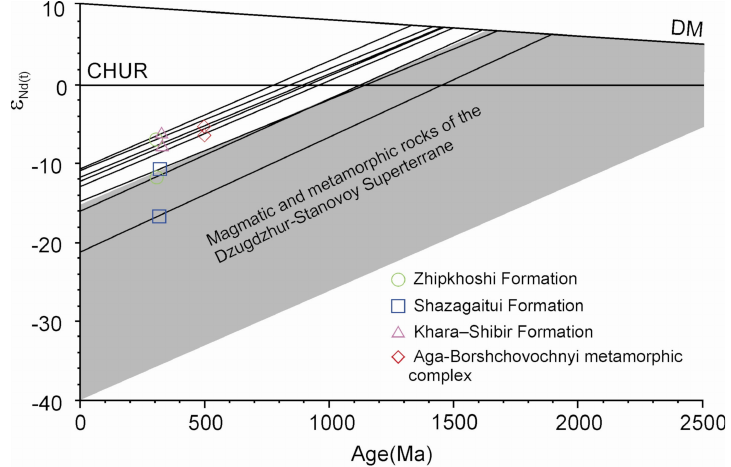
Figure 9. Plots of crystallization age (Ma) versus ε Nd(t) values for Aga–Borshchovochnyi metamorphic complex and siliciclastic rocks of the Chiron Basin (black lines, data from Table 2), in comparison with whole-rock compositions of the magmatic and metamorphic rocks of the Dzhugdzhur-Stanovoy Superterrane (grey field, data from